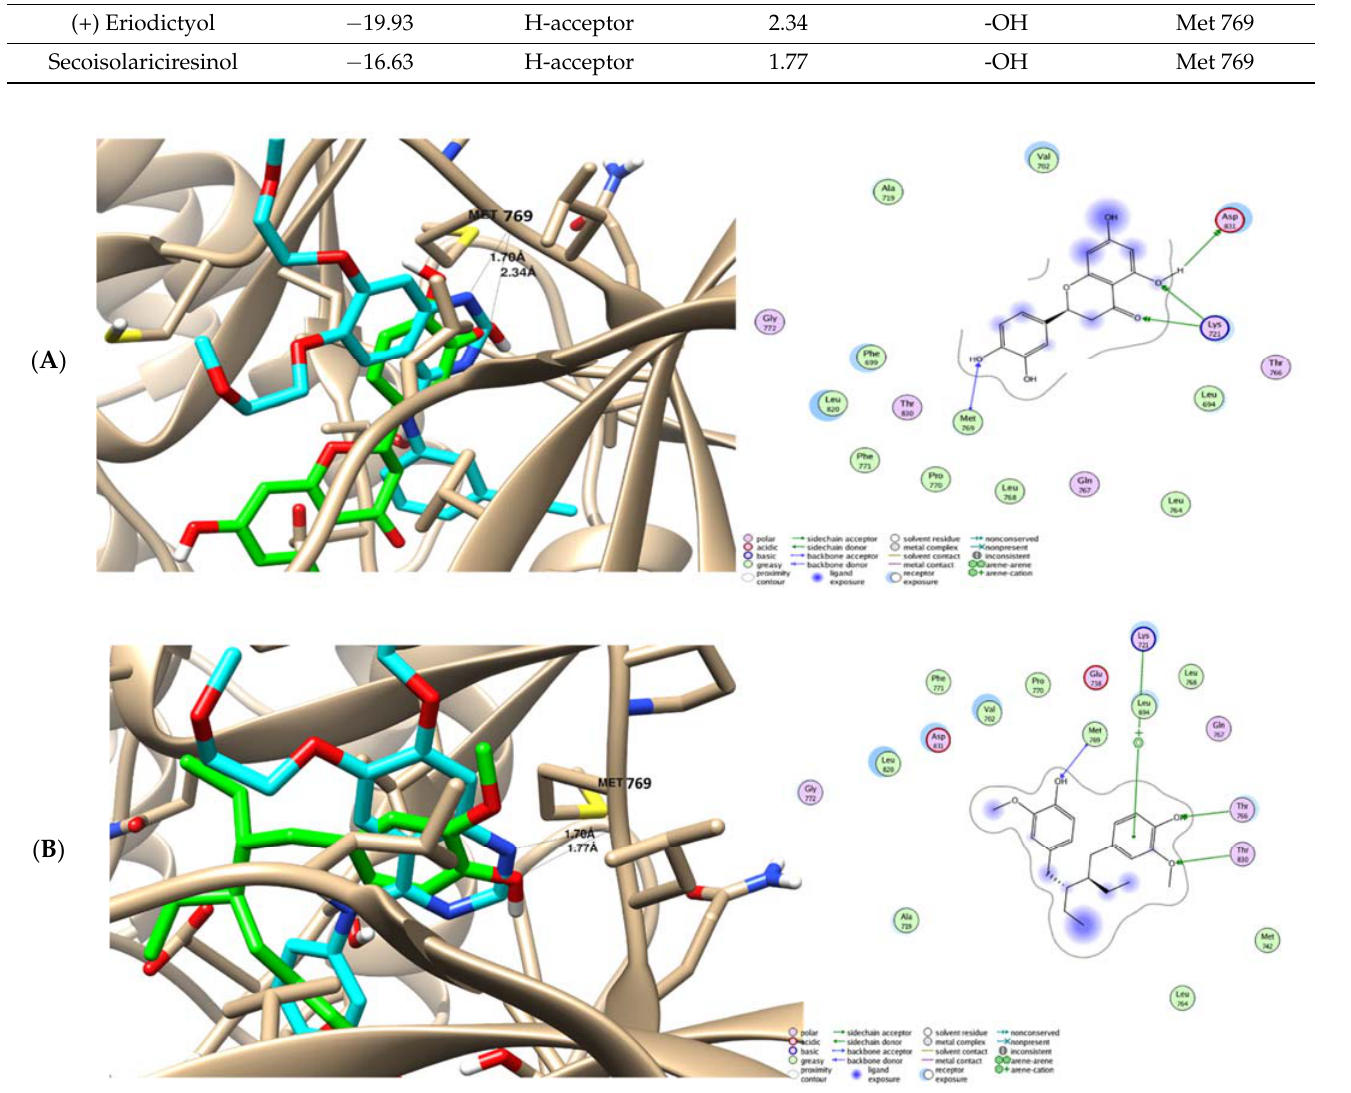
Figure 2. Binding disposition and analysis of ligand ‒ receptor interactions of the two docked compounds inside the EGFR protein: ( A ) (+) eriodictyol and ( B ) secoisolariciresinol, with 2D and 3D interactive images. The co-crystallized ligand is cyan-colored, while the docked compounds are green-colored. The EGFR protein (PDB = 1M17) was freely accessible from the protein data bank. 2.4. Compounds (+) Eriodictyol and Secoisolariciresinol Inhibited